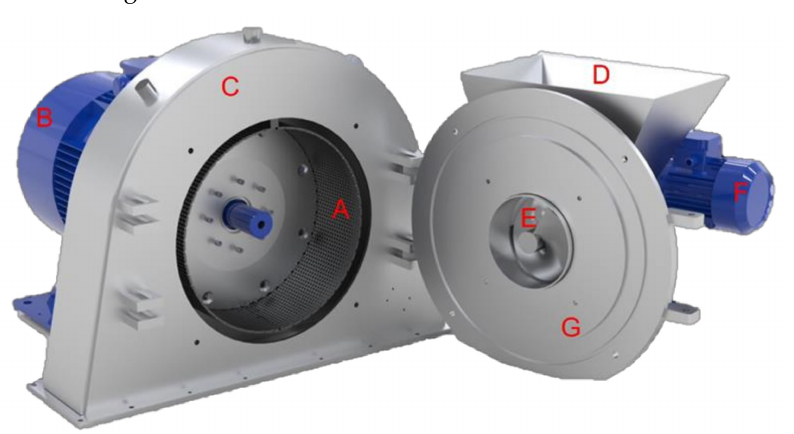
Figure 1. Crusher machine: (A) grid, (B) electric motor for rotor, (C) crankcase, (D) loading hopper, (E) feeding screw, (F) electric motor for feeding screw, (G) inspection hatch.